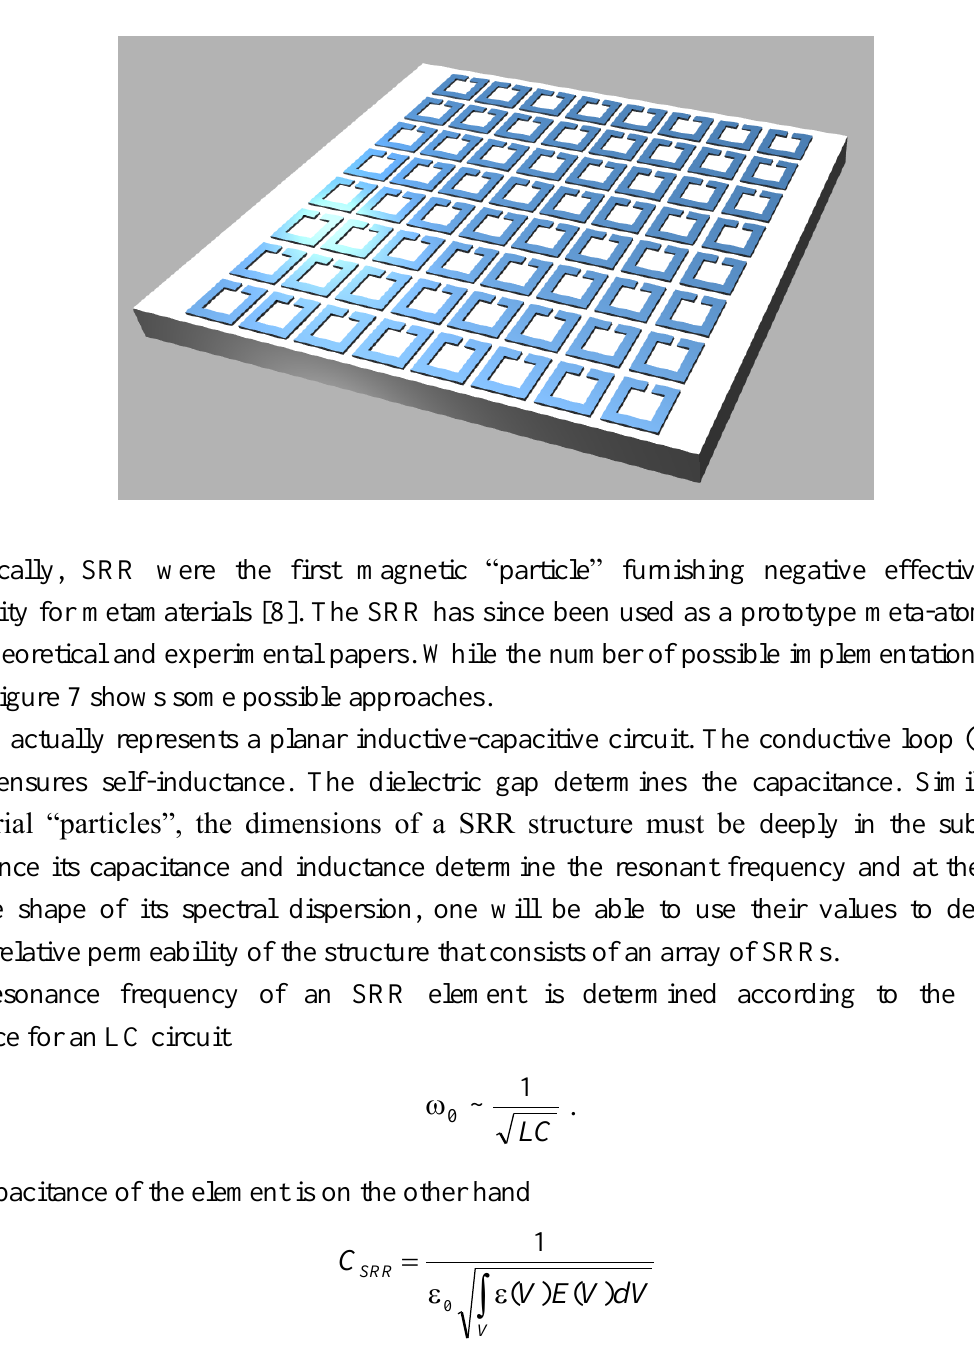
Figure 6. A prototype magnetic metasurface: an array of split ring resonators stacked in a square 2D